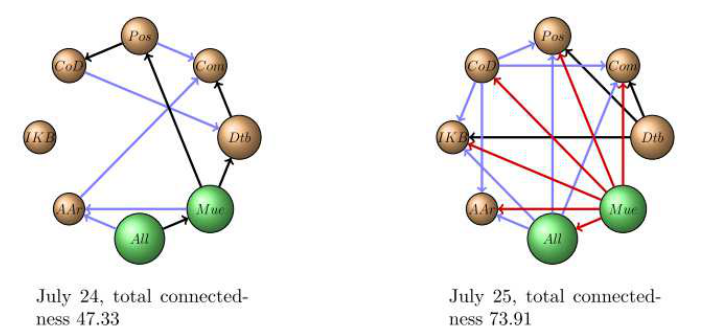
Fig. 6. For description, see figure